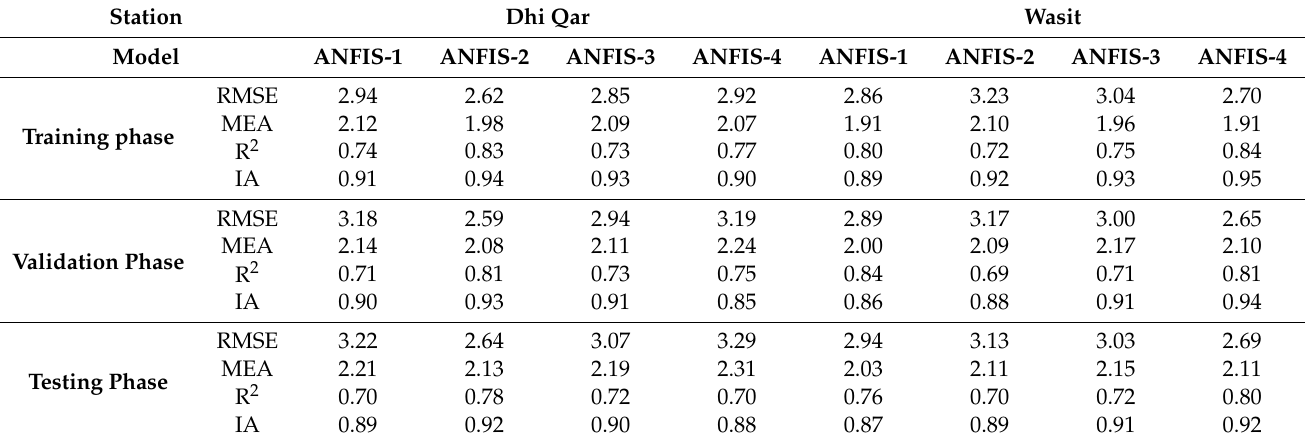
Table 4. The results of statistical analysis of different input patterns of ANFIS model in Rs